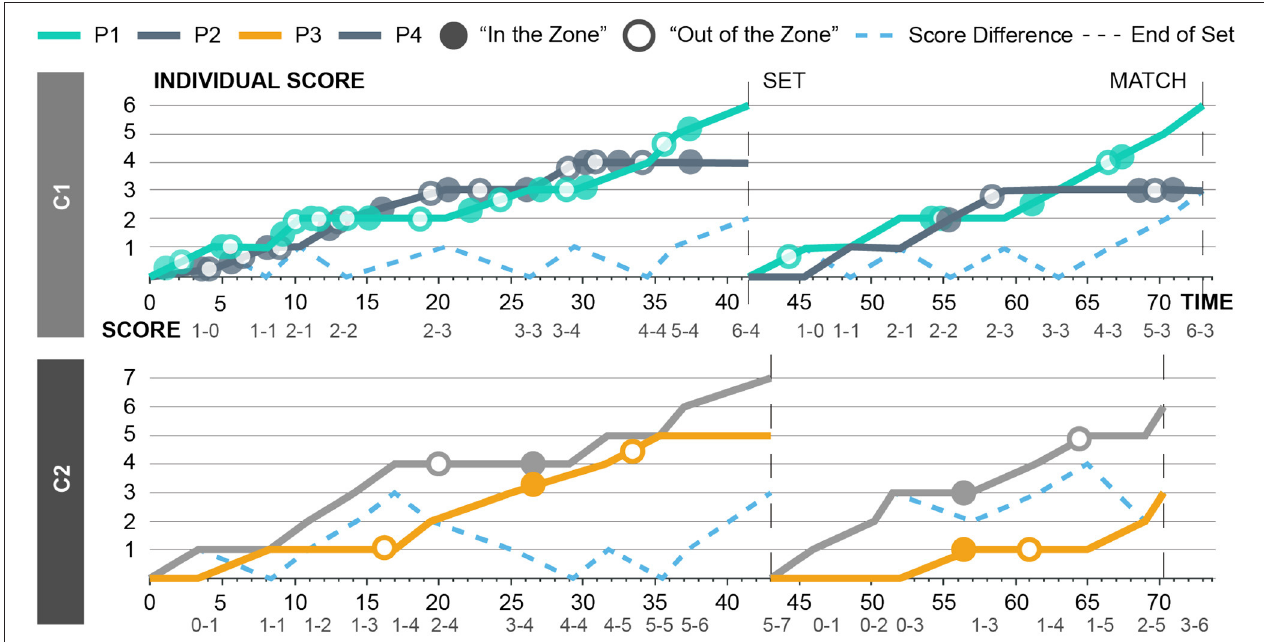
FIGURE 2 | Labels of coaches, C1 (top) and C2 (bottom), for their respective players (P1 and P2, P3 and P4) according to individual scores and score